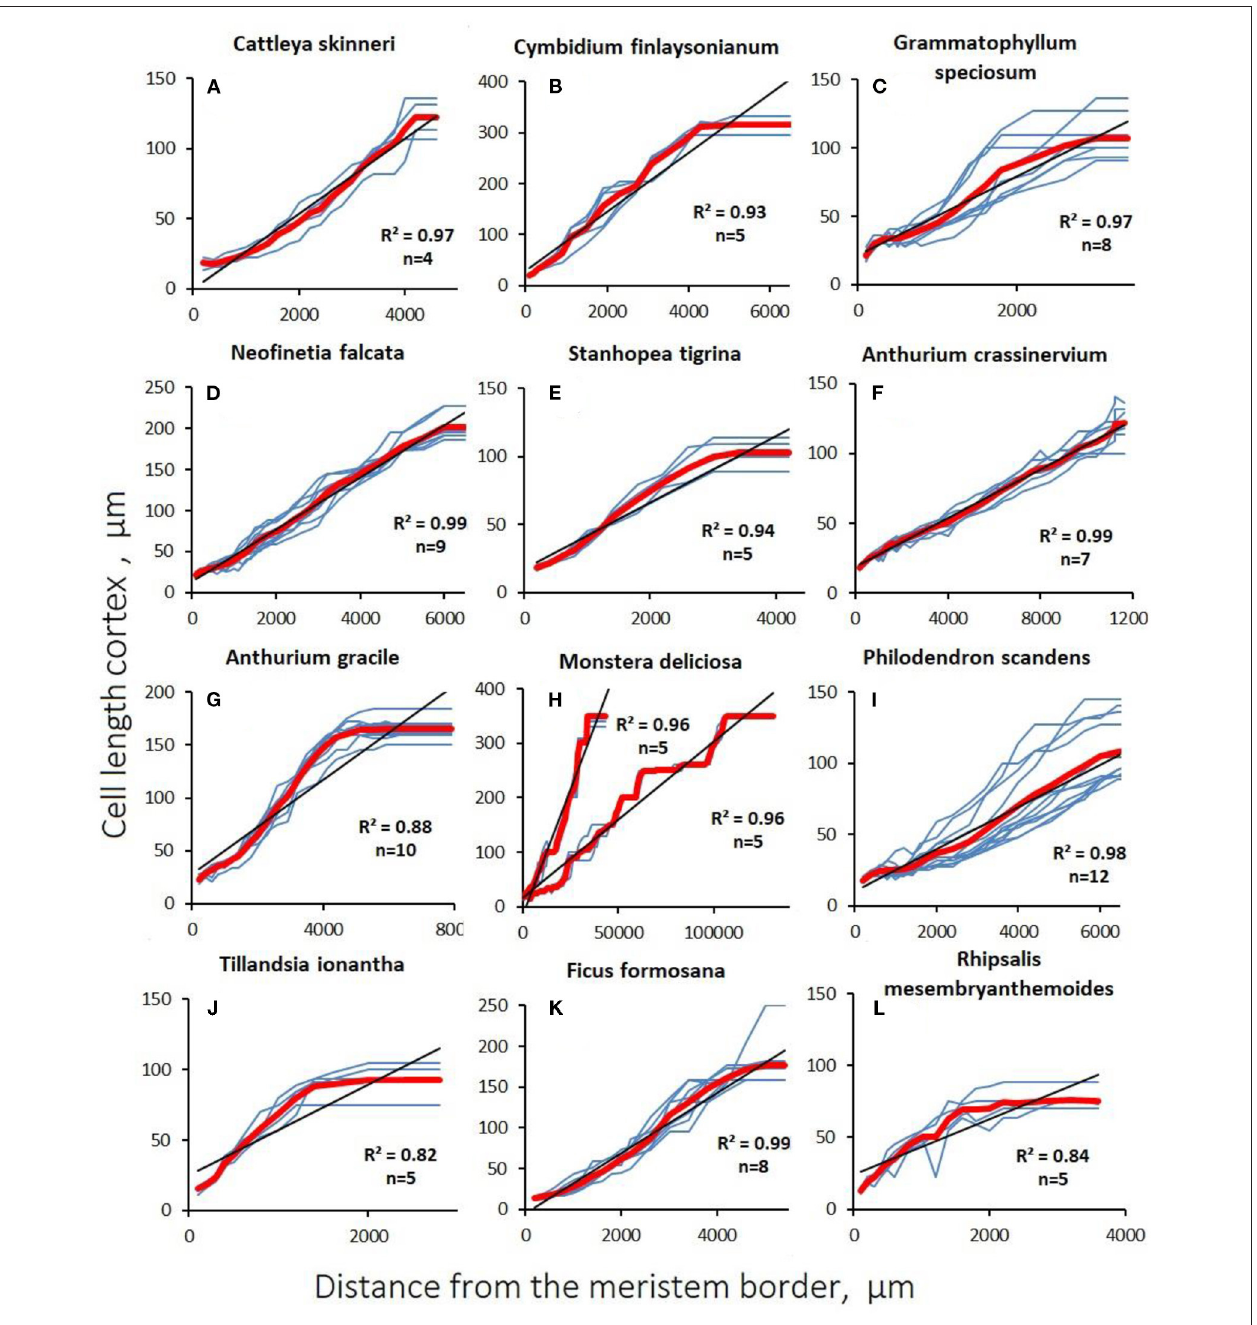
FIGURE 4 | Changes in cortex cell length with distance from the apex (distal apical meristem border) in aerial roots. Blue lines are data for a single studied root section of the root. The red line is the average value. The coefficient of determination is given to the average value, ( n ) is the number of sections examined. (A–E) Orchidaceae; (F–I) Araceae; (J) Bromeliaceae; (K) Moraceae; (L) Cactaceae.